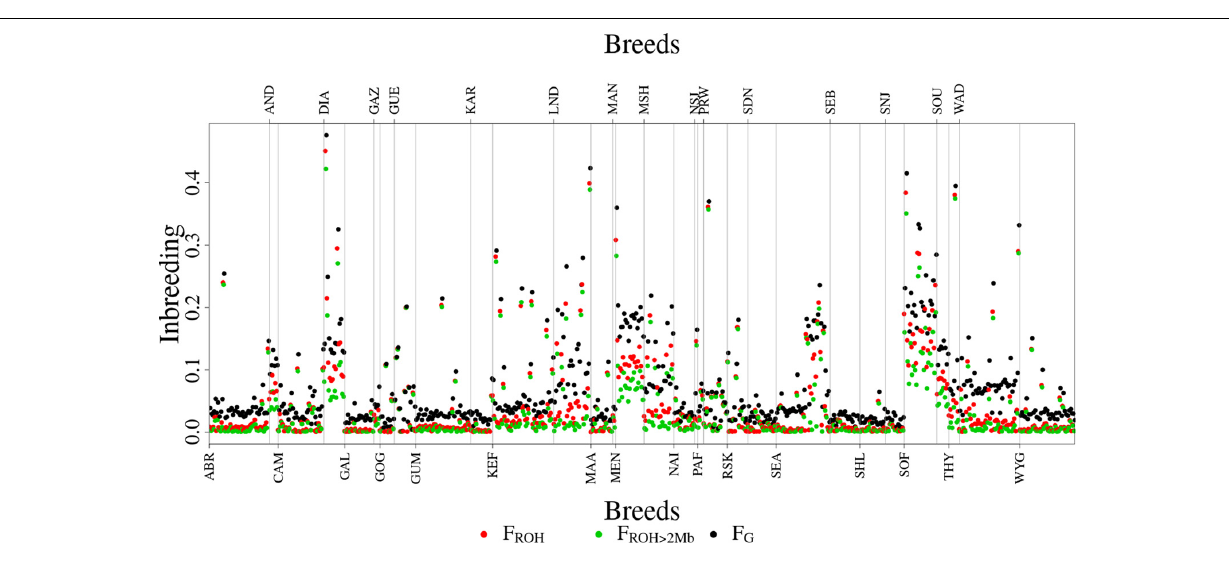
Table 1 . The overall correlations between F ROH and the other metrics (F ROH > 2Mb and F G ) were 0.99 and 0.97, respectively, while the correlation between F ROH > 2Mb and F G was 0.93. In the correlation between F ROH > 2Mb and F G , small values deviated significantly from the linear plot ( Figure 7